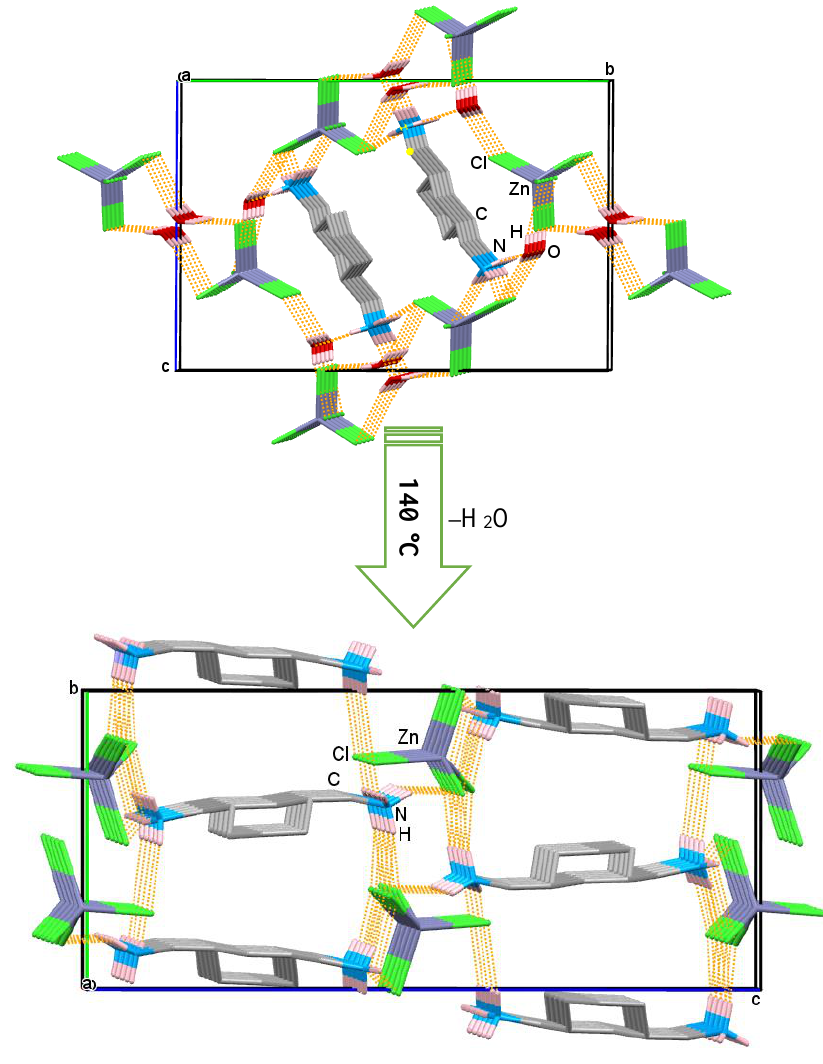
Figure 7. Single-crystal-to-single-crystal irreversible phase transition for compound (CHBMAH 2 )ZnCl 4 · 2H 2 O 2 ( above ) to compound (CHBMAH 2 )ZnCl 4 4 ( below ). Cell axes: a , b , c .